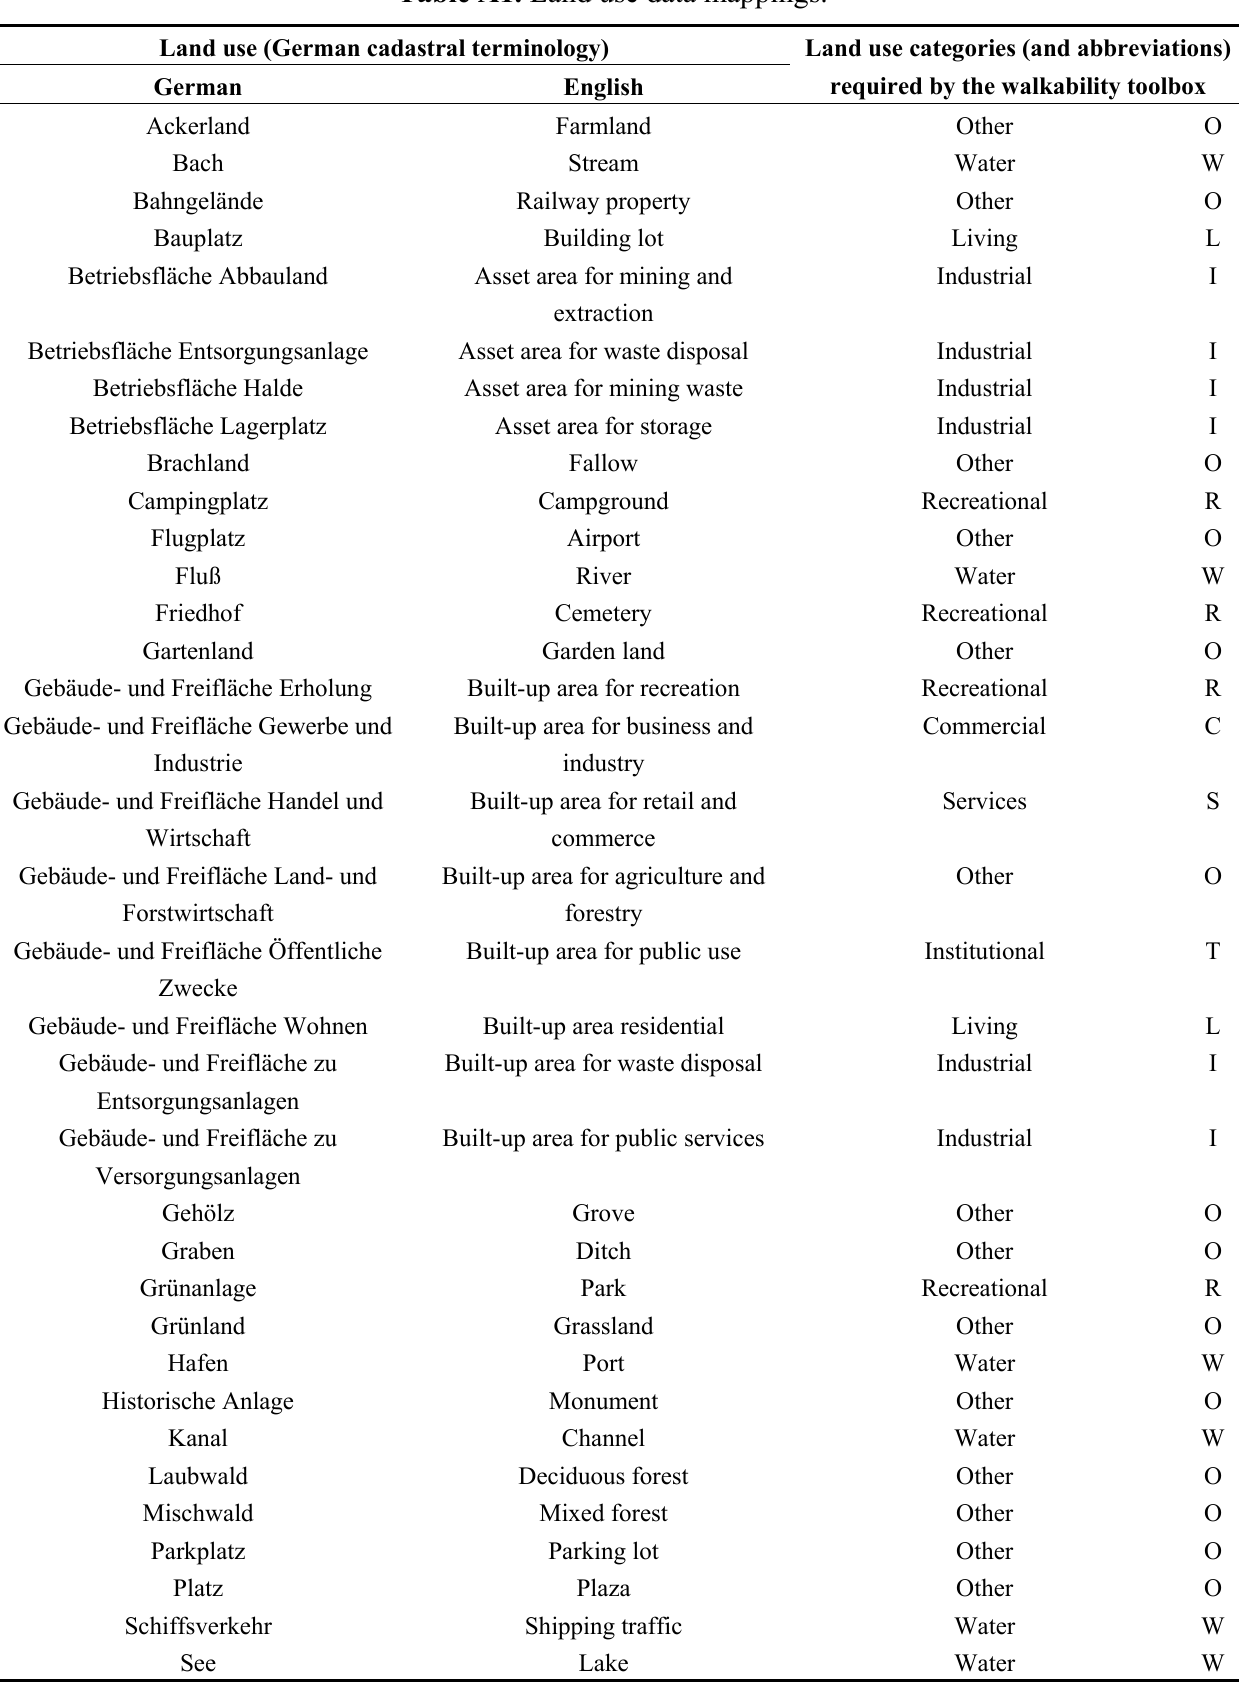
Table A1. Land use data